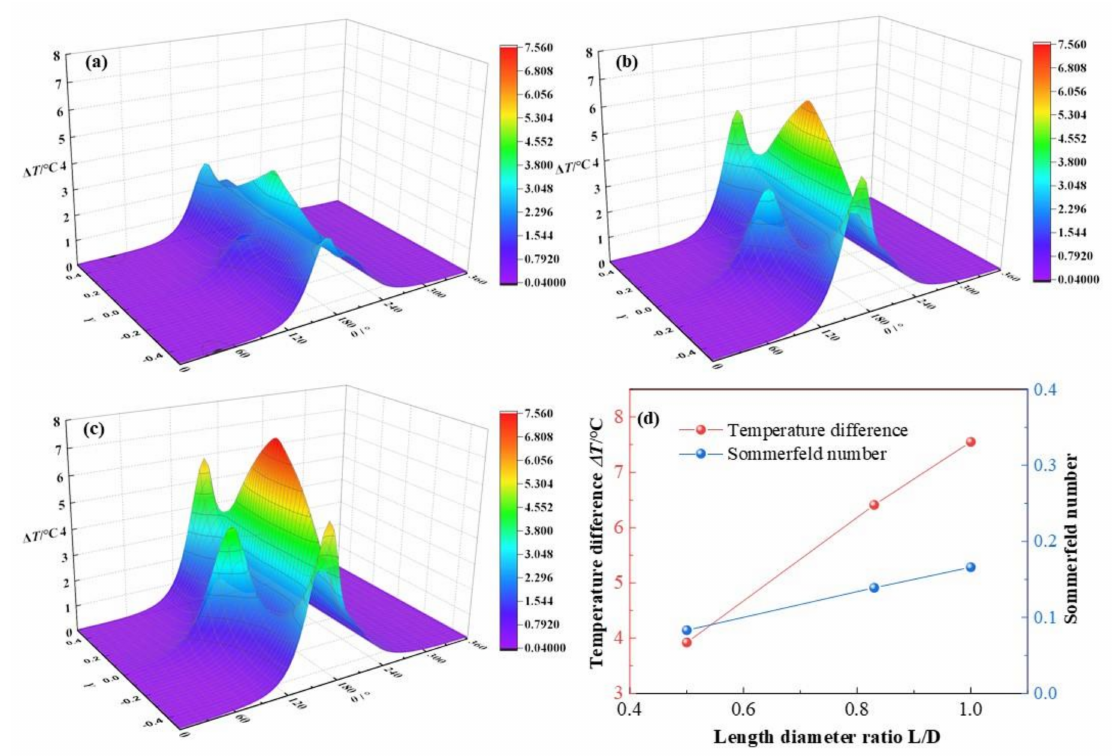
Figure 12. Comparison of the temperature distribution under different length diameter ratios. ( a ) L / D = 0.5; ( b ) L / D = 0.83; ( c ) L / D = 1.0; ( d ) maximum temperature.